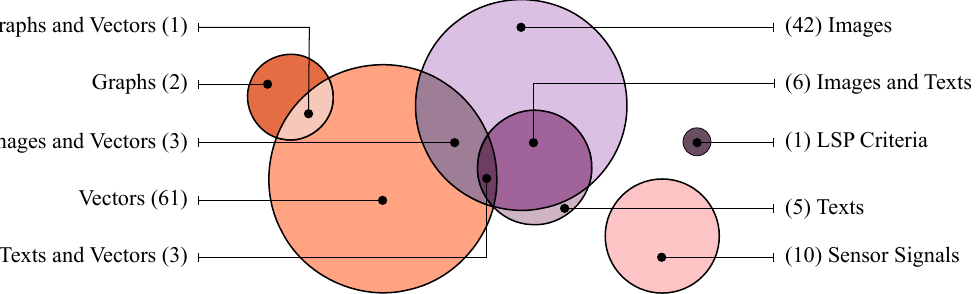
Figure 10. Venn diagram with the number of articles using different forms of data to assess the functional validity of the proposed XAI methodologies. The sizes of the circles are approximately proportional to the number of articles (shown within parentheses) that were observed in this re- view